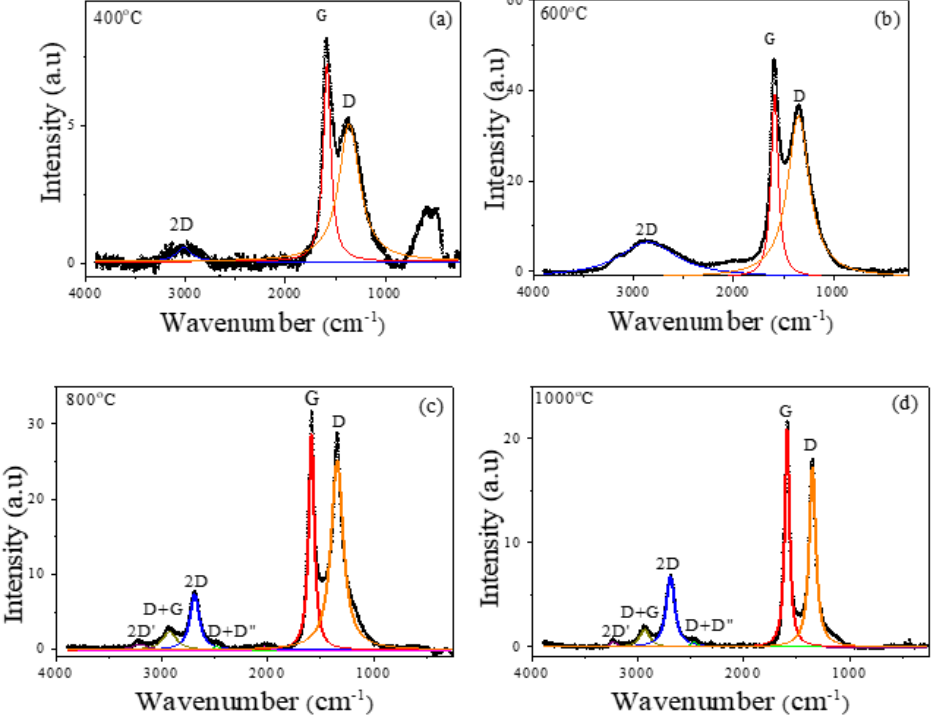
Figure 5. Raman spectra of the annealed samples at ( a ) 400 °C, ( b ) 600 °C, ( c ) 800 °C, and ( d ) 1000 °C. Solid lines: Lorentz peak deconvolution.